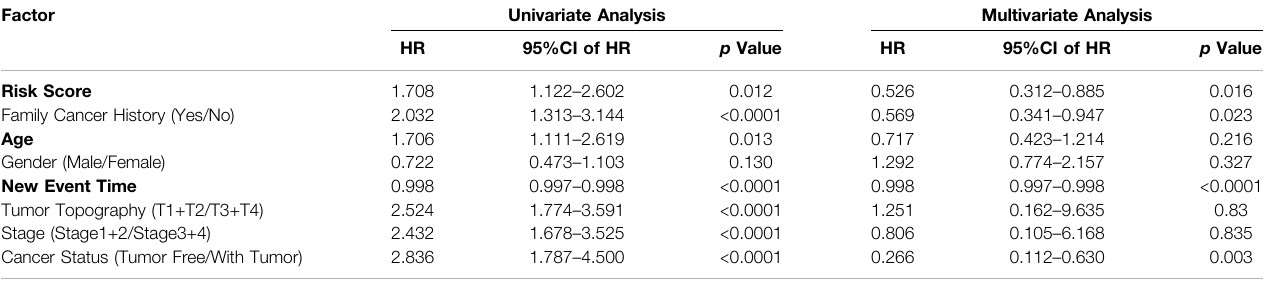
TABLE 4 | Univariate and multivariate analyses for predictors of overall survival of hepatocellular carcinoma patients in TCGA. Factor